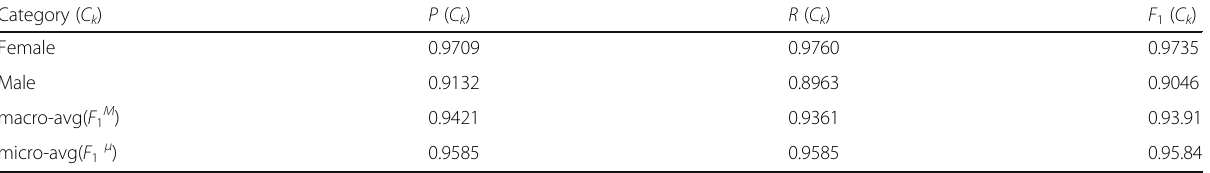
Table 2 Performance measure with context window using cross validation =